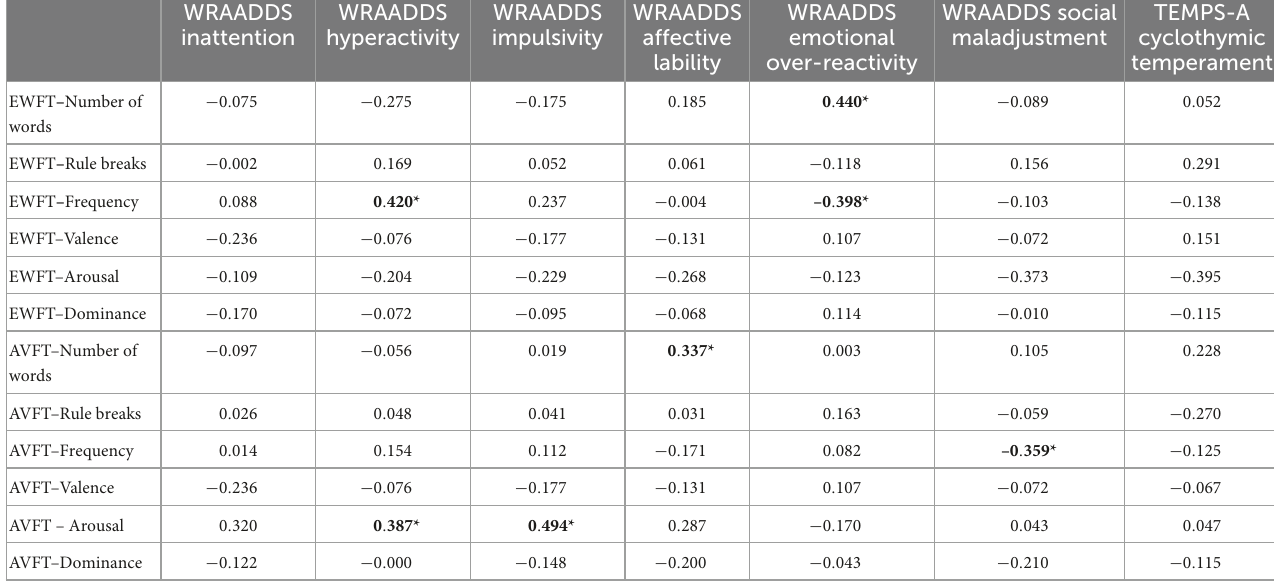
ASD (AS) Statistical ( N = 12)